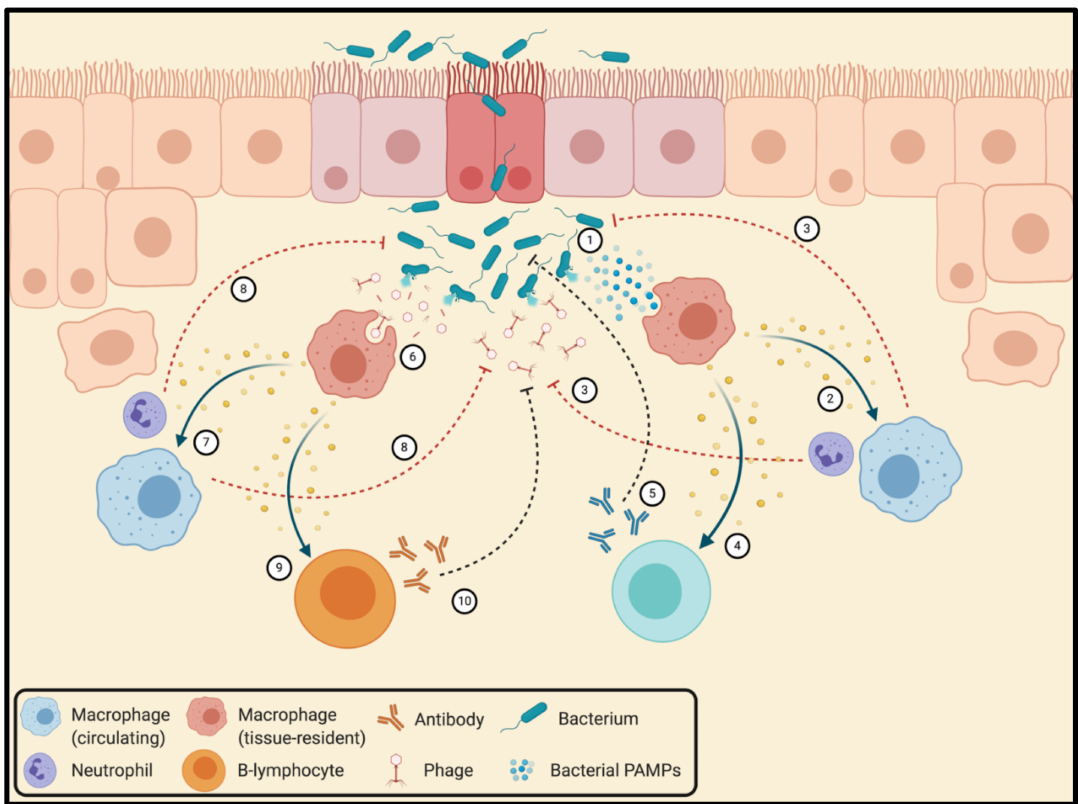
Figure 4. Interactions between bacteriophages and the mammalian immune system. In addition to their direct anti-bacterial action via killing of target bacterial cells, phages can contribute to bacterial killing indirectly by stimulating the host immune system—a multifactorial process that can be divided into two main pathways. At the infection site, phage-mediated lysis of bacteria induces the release of bacterial pathogen-associated molecular patterns (b-PAMPs), which trigger the activation of tissue-resident macrophages ( 1 ). Upon activation, these macrophages use cytokine signaling to activate circulating macrophages and neutrophils and recruit them to the infection site ( 2 ), where they indiscriminately eliminate phages and bacteria alike via phagocytosis followed by ROS-mediated degradation ( 3 ). Furthermore, cytokine signaling by b-PAMP-activated tissue-resident macrophages leads to the activation and recruitment of B-lymphocytes ( 4 ), which subsequently initiate a specific humoral response against invading bacteria ( 5 ). Simultaneously, phage particles (and fragments thereof) introduced through treatment and reproduced via the lytic cycle stimulate the activation of other tissue- resident macrophages ( 6 ), which similarly recruit circulating macrophages and neutrophils ( 7 ) that subsequently eliminate both bacteria and phages via indiscriminate internalization and degradation ( 8 ). Finally, tissue-resident macrophages may activate circulating B cells through presentation of phage peptides ( 9 ), leading to a specific humoral response against phage particles ( 10